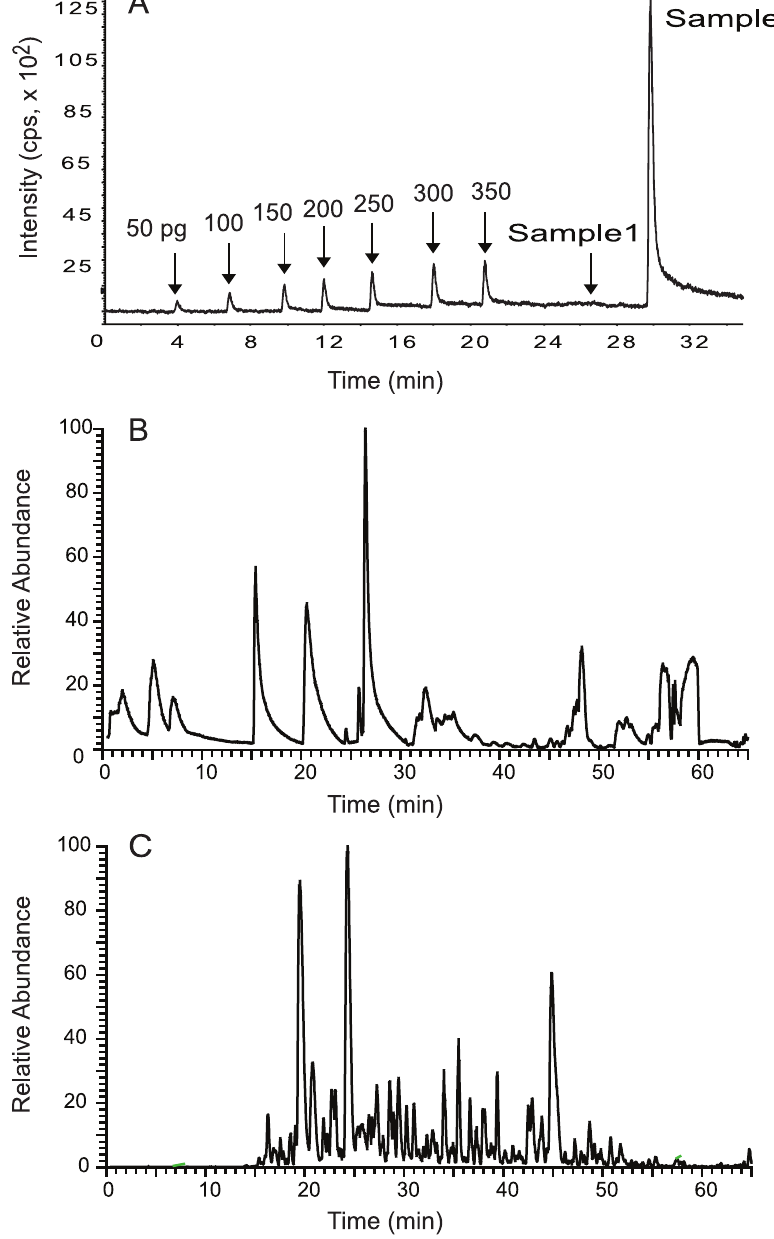
Figure 3. Total ion current chromatograms of the tryptic digest of OS membrane proteins. (A) Residual PFOA in the tryptic digest of OS membrane proteins quantified by flow injection analysis. Different concentrations of the PFOA standard solution (50–350 pg) and samples in 1 m L